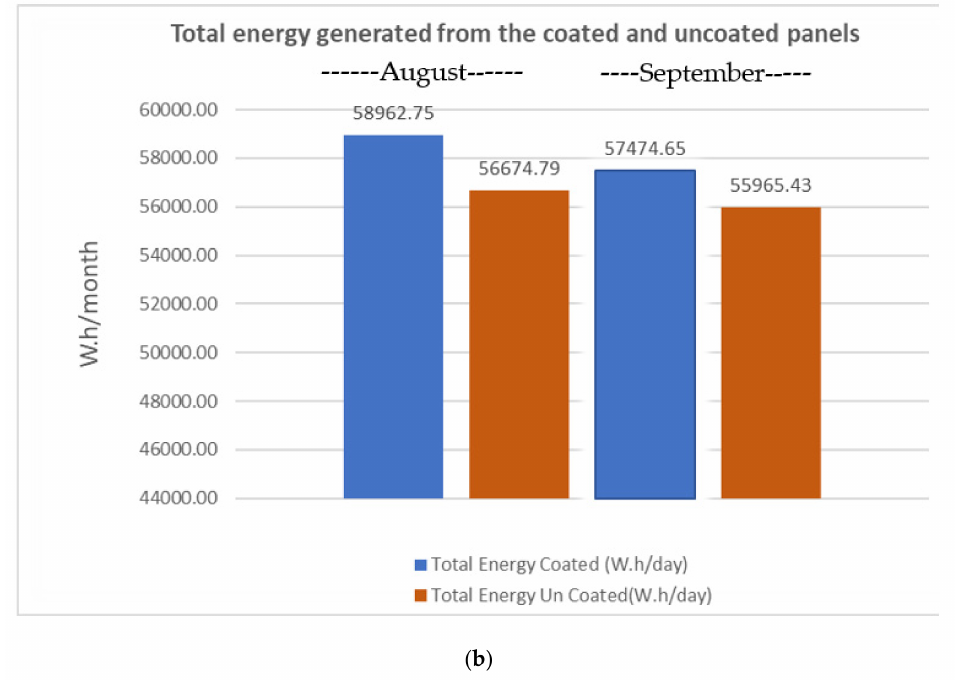
Figure 14. ( a ) Average coated and uncoated efficiency over the two-month period. ( b ) Total energy generated from the coated and uncoated panels in August and September.